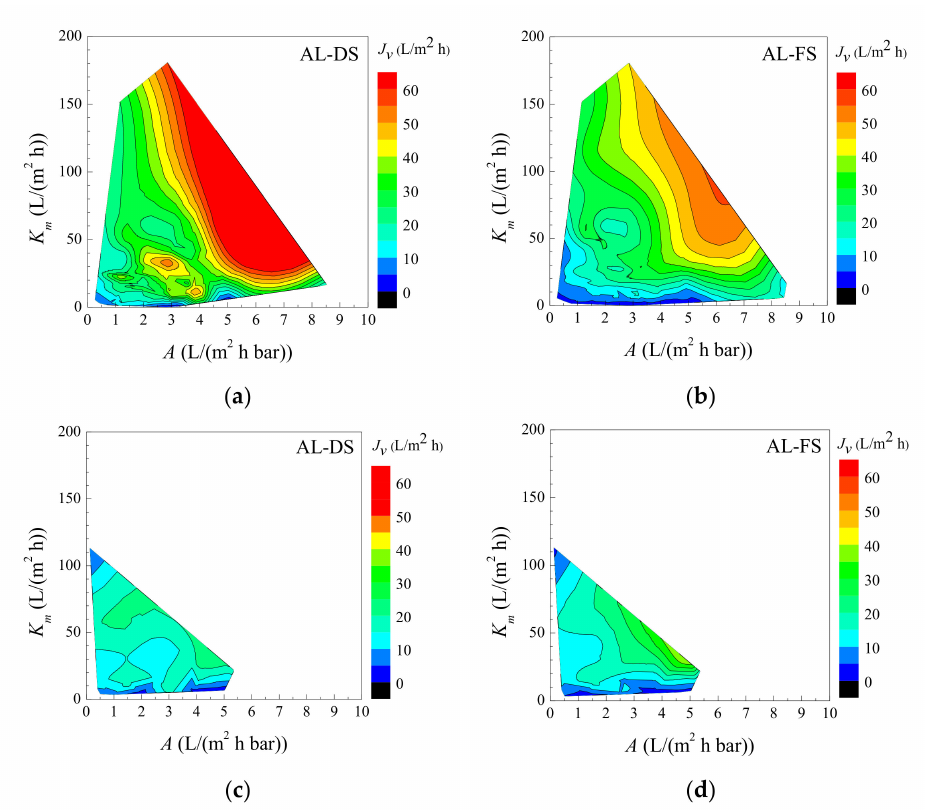
Figure 7. FO water flux of membranes with different water permeability ( A ) and mass diffusion coefficient ( K m ). The data was obtained from the experiments in the current work and the literature, and the membrane properties are presented in Table A1 and Table S1. Data in ( a , b ) were evaluated with FS of 0–10 mM NaCl and DS of 0.5–0.75 M NaCl. Data in ( c , d ) were evaluated with FS of 0.5–0.6 M NaCl and DS of 1.5–2 M NaCl.